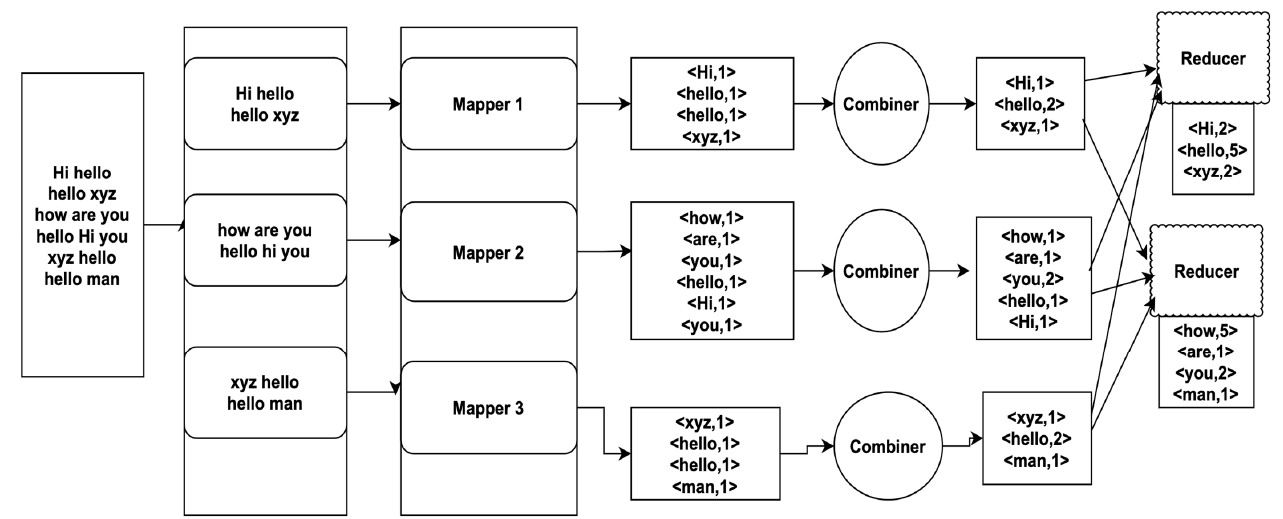
Figure 2. MapReduce using